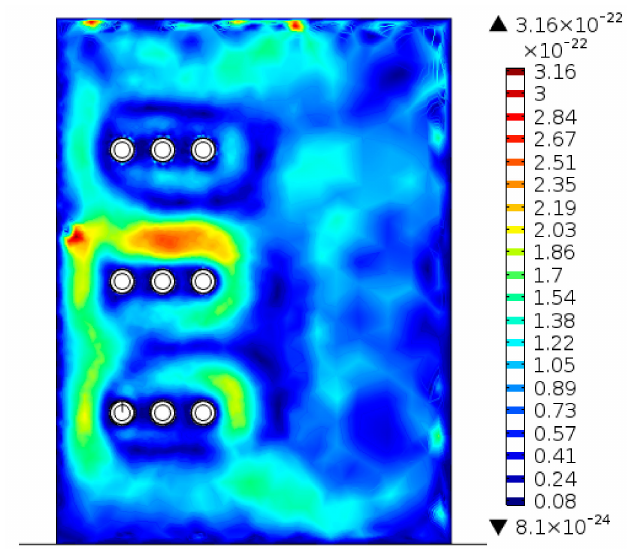
Figure 6. Air flow field distribution (unit: m / s).